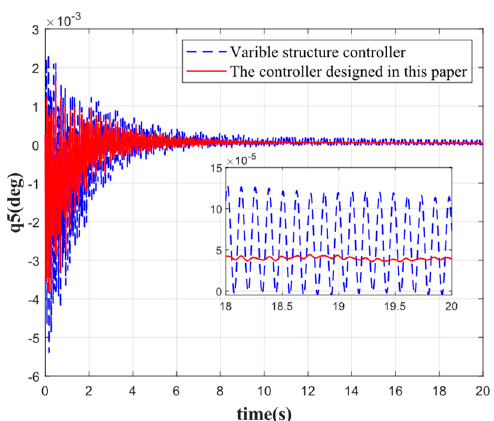
Figure 8. Fourth ‐ order elastic vibration mode without external interference. Figure 8. Fourth-order elastic vibration mode without external interference.